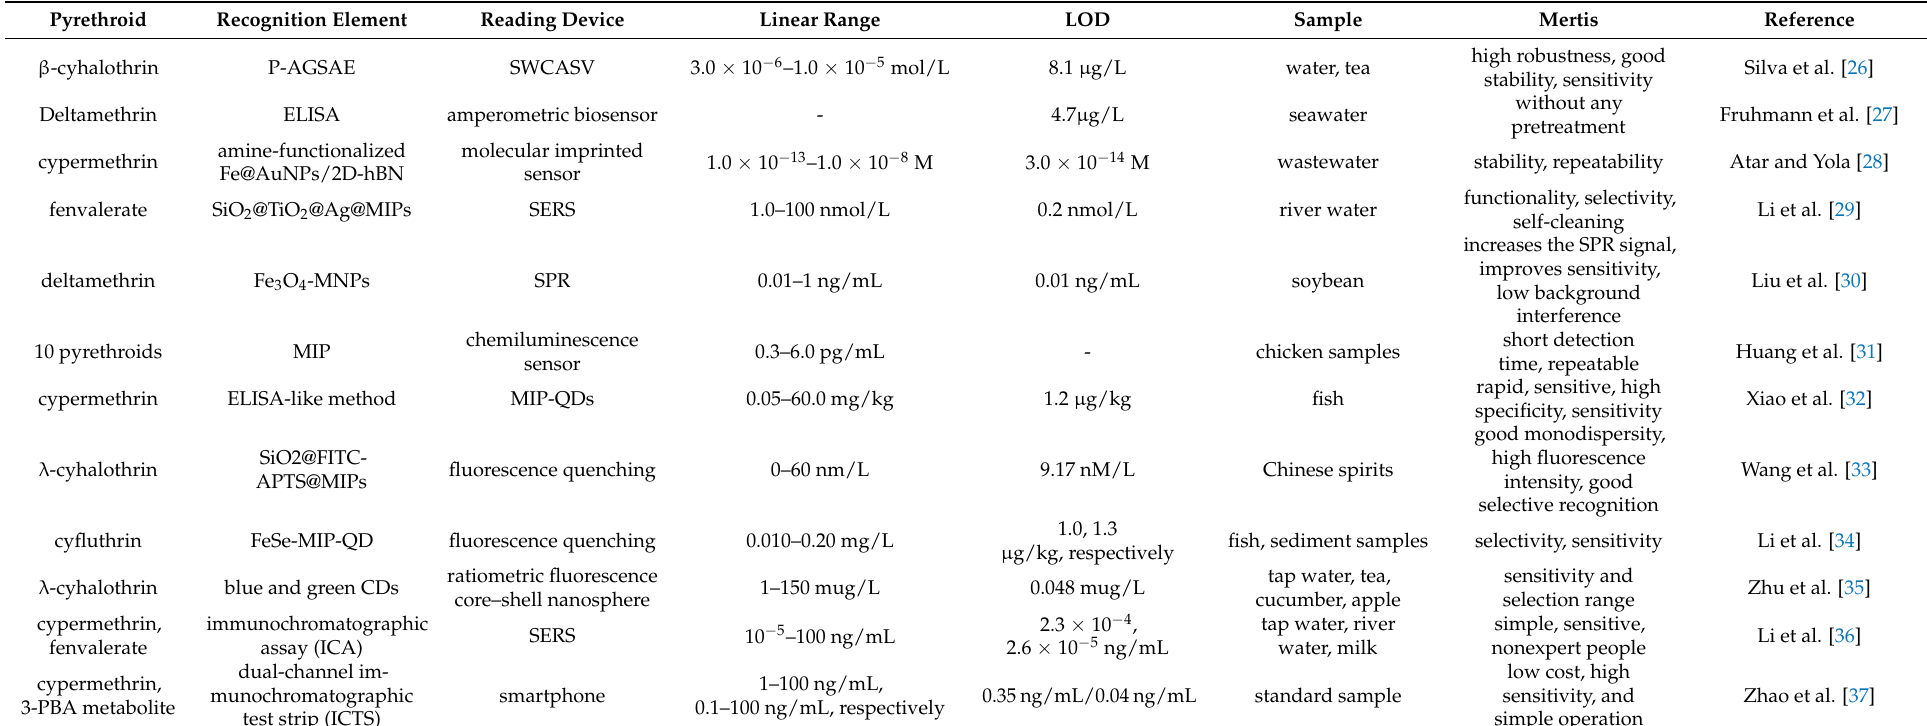
Table 1. Representative examples of pyrethroid residue detection based on